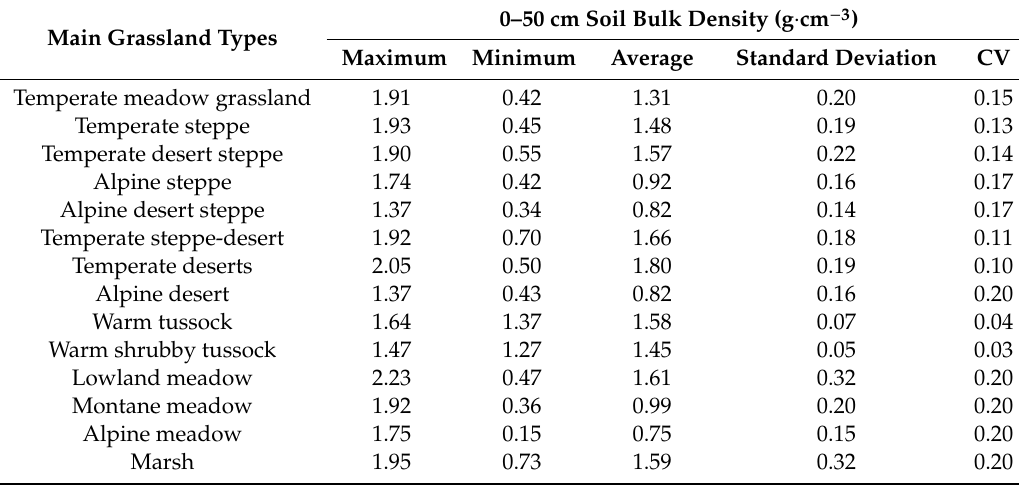
Table 3. Statistical analysis in di ff erent grassland